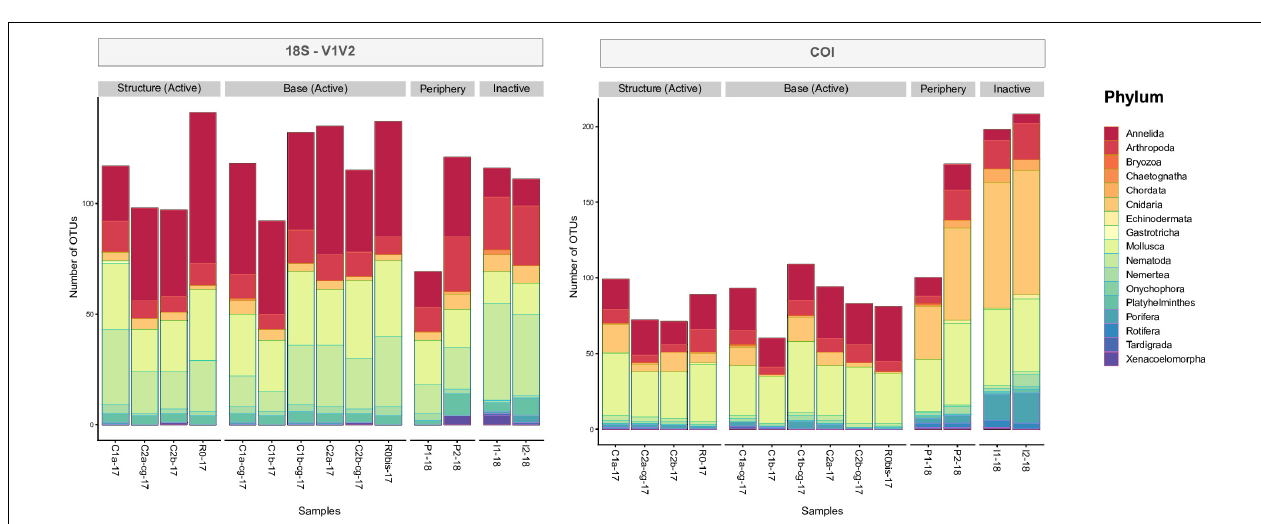
FIGURE 6 | Canonical correspondence analysis (CCA) plots for 18S-V1V2 and COI, illustrating metazoan community distributions by active, periphery or inactive habitats. Shapes denote habitat type and location (active only) and the number of shapes corresponds to the number of eDNA samples retrieved from each habitat. Colors refer to year and ellipses identify the relationships within habitats. The environmental gradient moves from right to left with increasing level of venting influence.